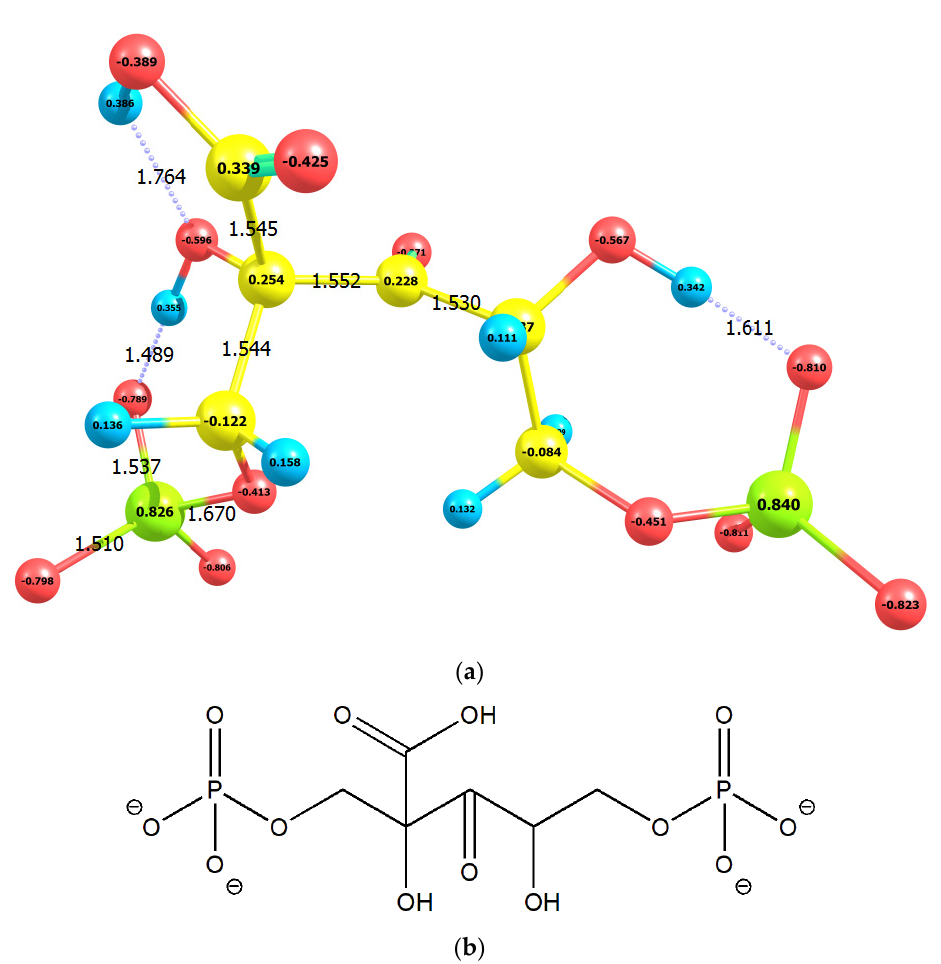
Figure A9. ( a ) The calculated geometric and electronic structure of 2-carboxy- D -arabinitol